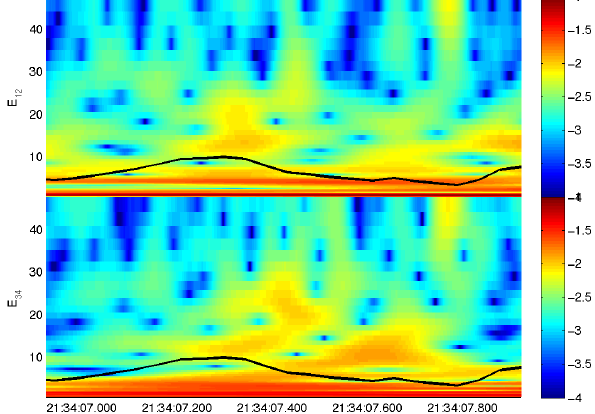
Fig. 11. The wavelet dynamic spectrum for event 3 (using the same format as Fig. 3.